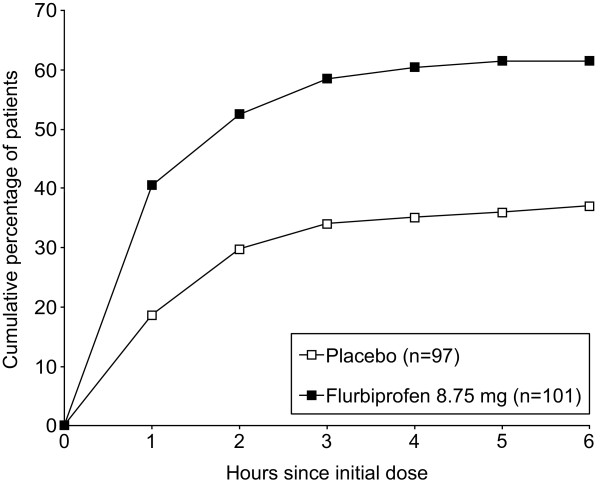
Cumulative percentage of patients achieving at least a 20% reduction from baseline in Sore Throat Pain Intensity Scale (STPIS) score.